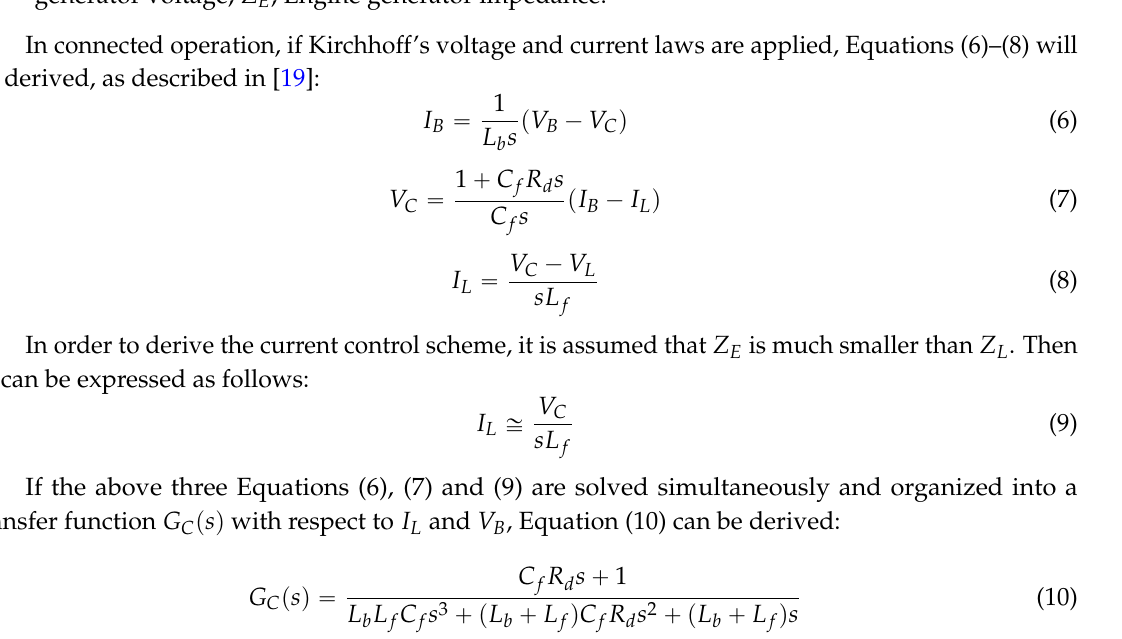
Figure 5. Current controller closed ‐ loop block diagram.